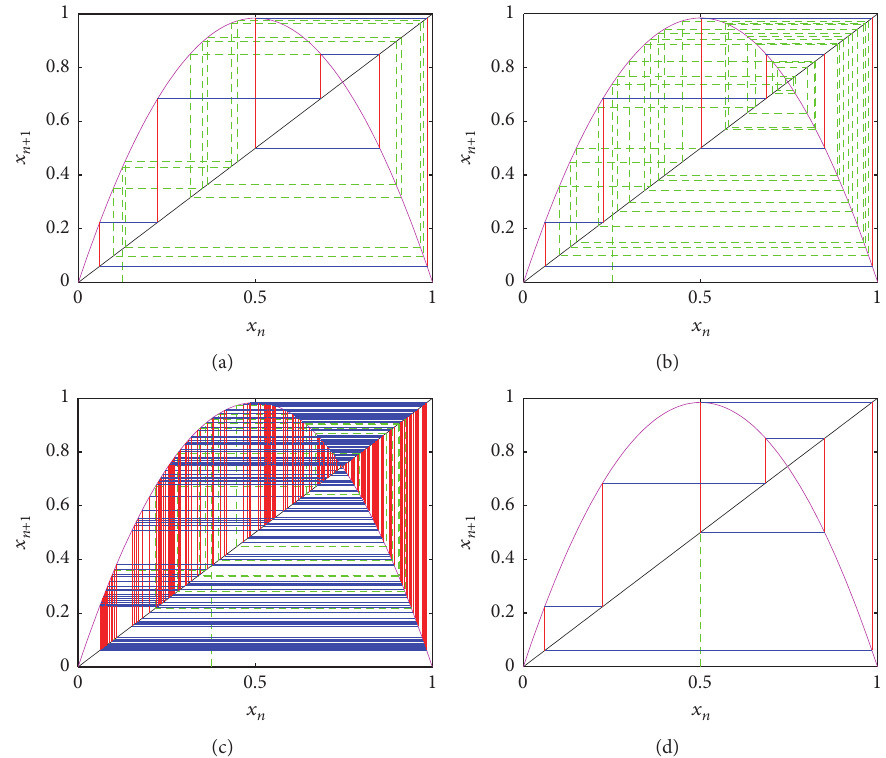
Figure 11: Cobweb plots of 𝑓 6 (𝑥) at 𝜆 = 3.9375 and 𝑝 = 20 starting at different initial conditions: (a) 𝑥 0 = 0.125 , (b) 𝑥 0 = 0.25 , (c) 𝑥 0 = 0.375 , and (d) 𝑥 0 = 0.5 .